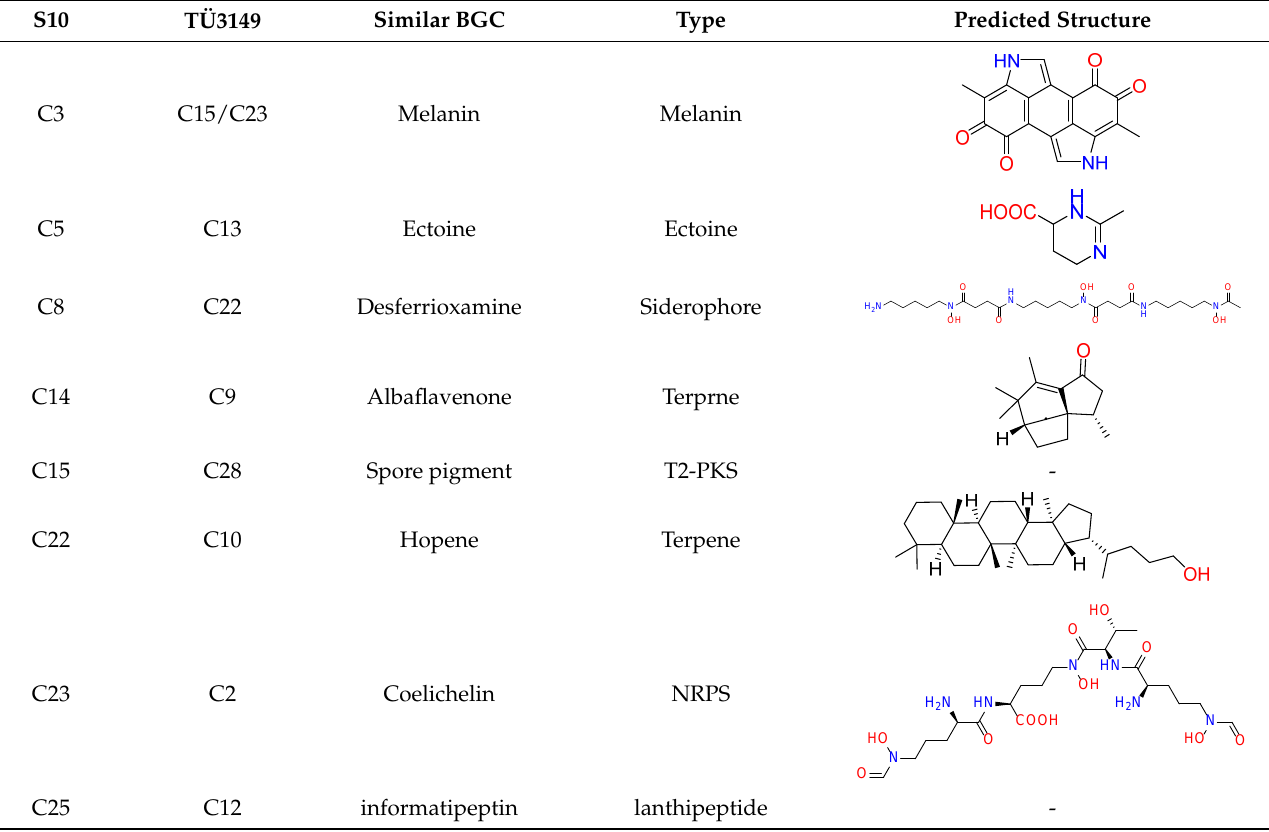
Table 2. Genome comparison between S. qaidamensis S10 and S. surantiogriseus TÜ3149.